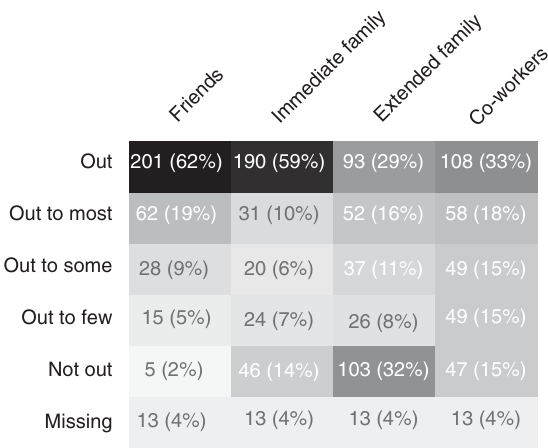
FIG. 2. Participant outness in different social